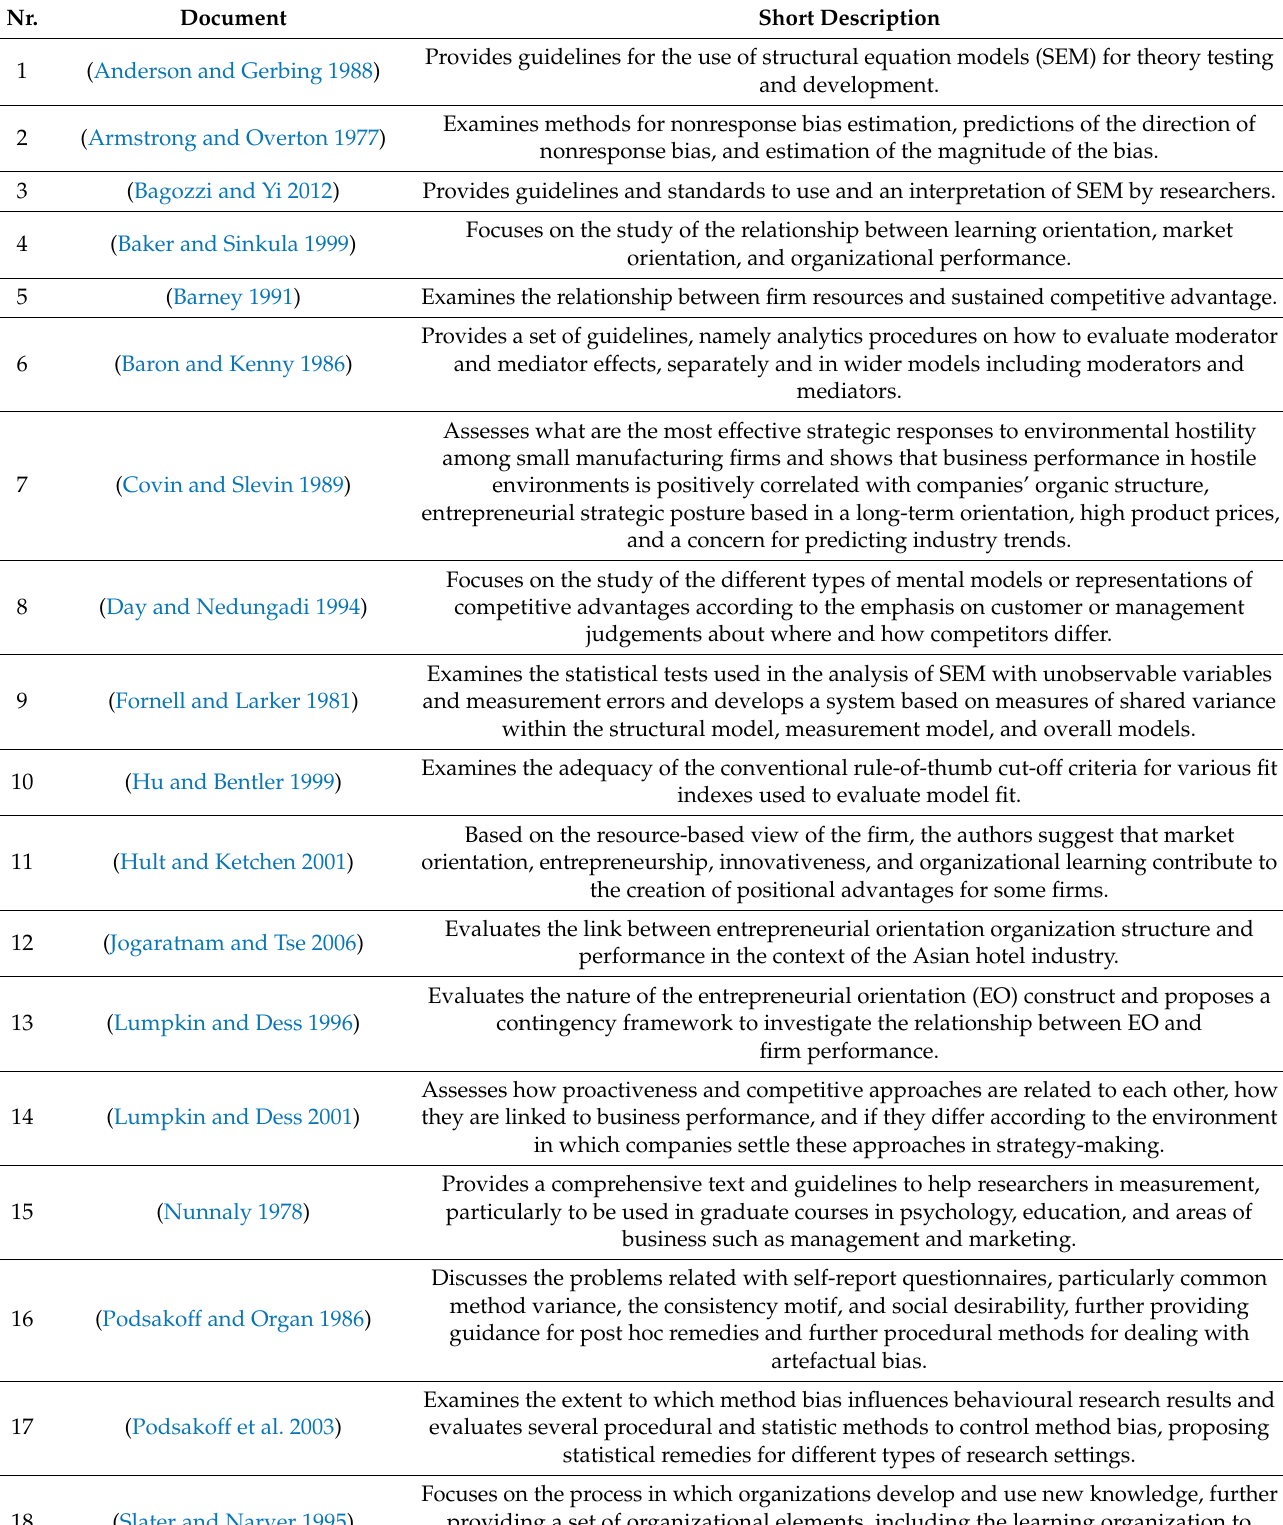
Table 3. Short descriptions of the cluster 2